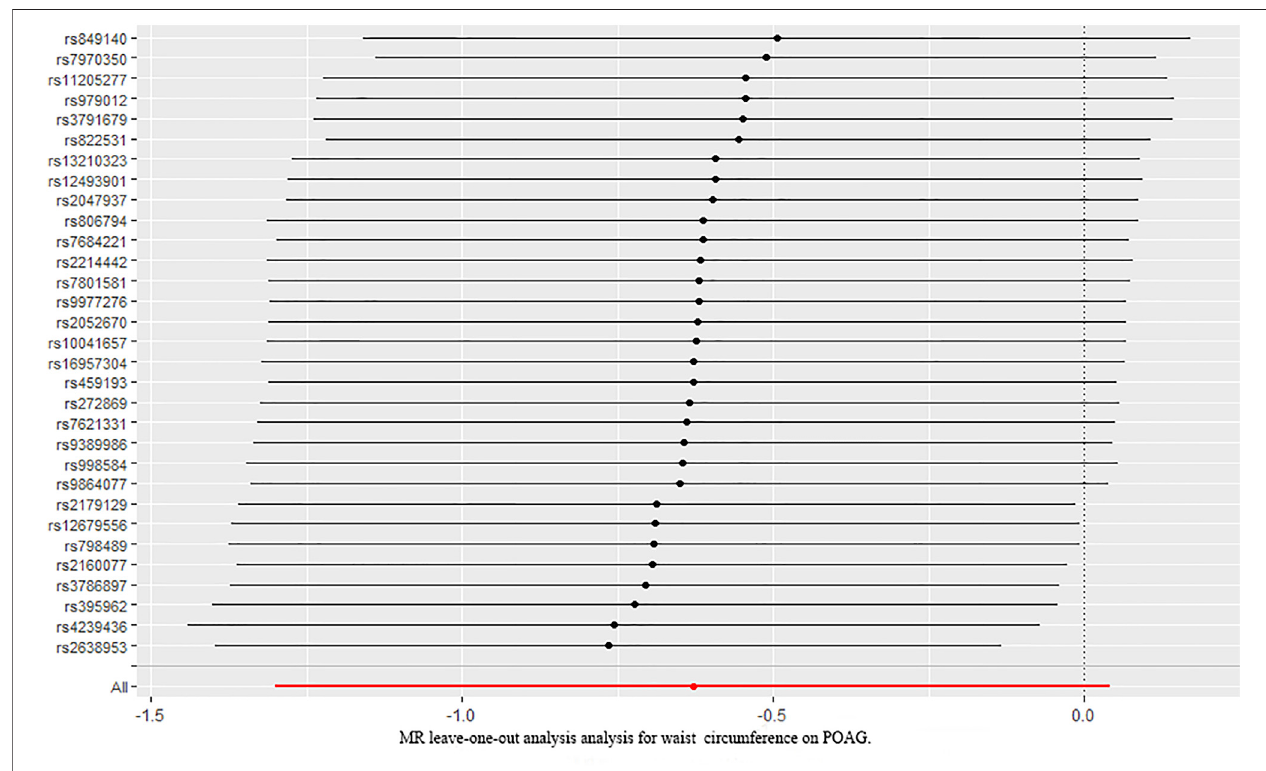
FIGURE 4 | Leave-one-out analysis plots for waist circumference on the risk of POAG. POAG: primary open-angle glaucoma; MR: Mendelian